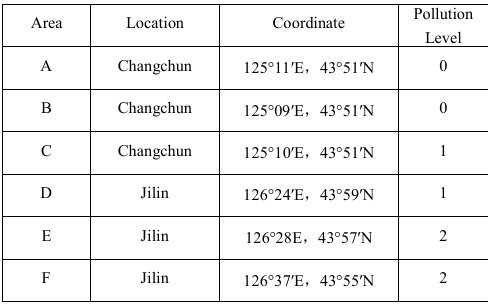
Table1. Location ofsamplesites